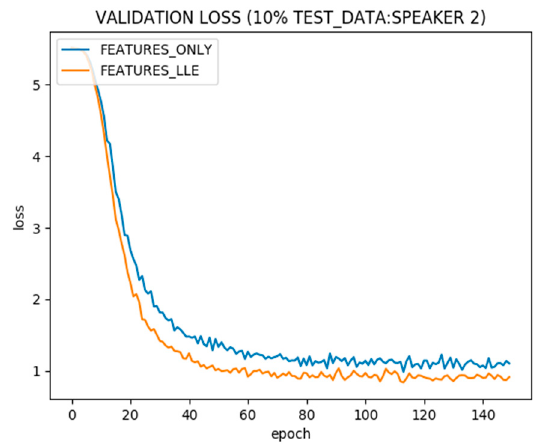
Figure 8. Test error vs. iterations with and without LLE (10% test and 90% training data).